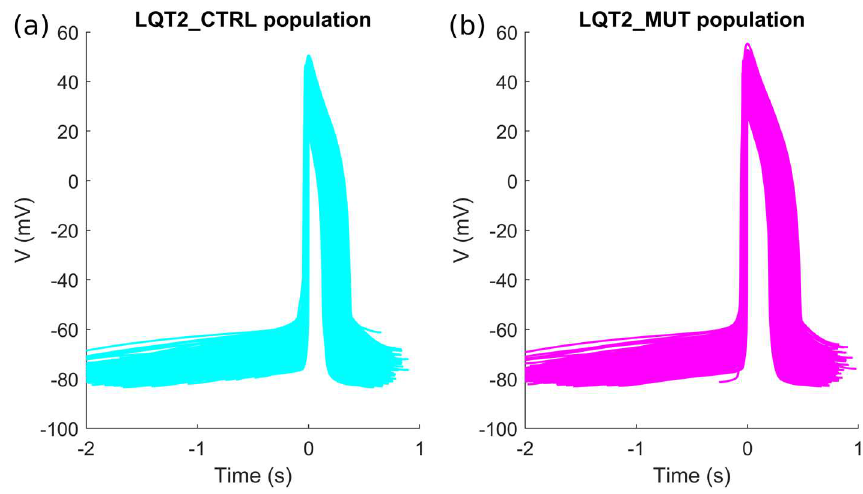
Figure 5. Action potentials included in the two populations built using the I Kr experiments by Bellin et al. [4]: ( a ) LQT2_CTRL; ( b ) LQT2_MUT. A magnified version of this figure is reported as Figure S4 in the supplementary material.